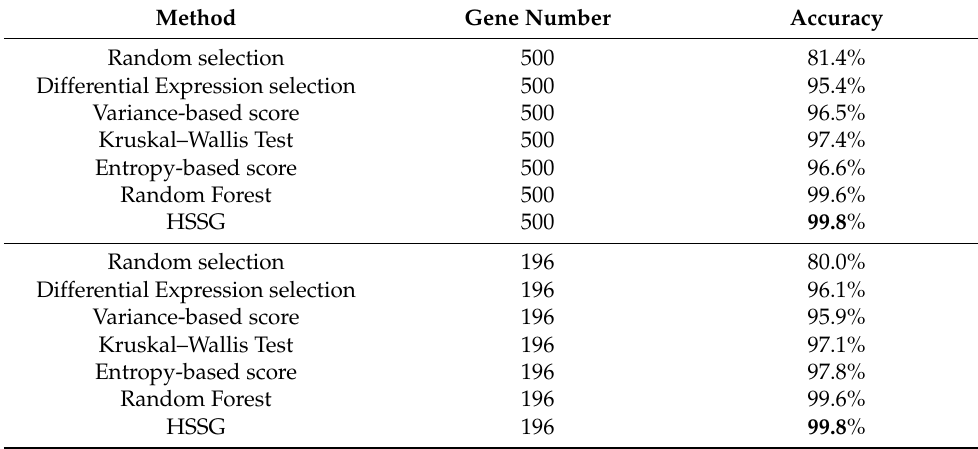
Table 5. Comparison with six popular feature scoring methods in selecting 500 and 196